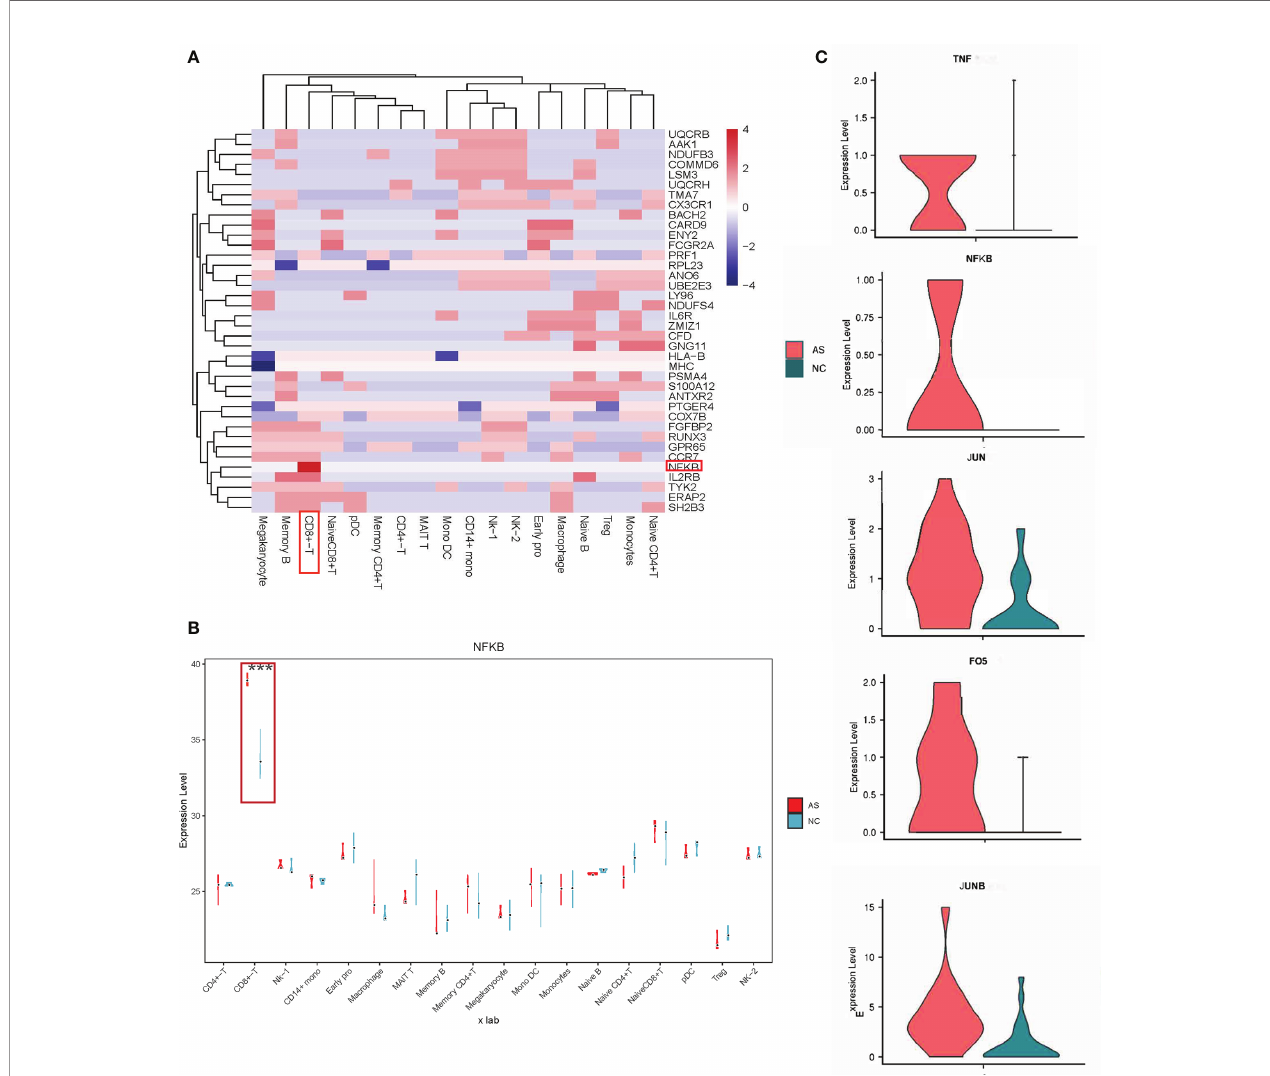
FIGURE 3 | Relationship between pathogenic genes and speci fi c cell types. (A) Heatmap representing the AS causal genes expression levels in the speci fi c cell type. The scale bar displays fold change values; Fold change value “ 0 ” is given for genes which are not DE, statistical signi fi cance was taken at P values of less than 0.05 (P < 0.05). and a fold-change criterion (FC>1.2); (B) Violin-box plots for NFKB expression level by cell type, compared to respective controls. The results for AS are shown in red, and those for NC are in green; ***p < 0.001. (C) Violin plots comparing the expression of selected genes ( TNF, NFKB, JUN, JUNB, FOS ) in CD8+T cells across AS and NC. The results for AS are shown in red, and those for NC are shown in